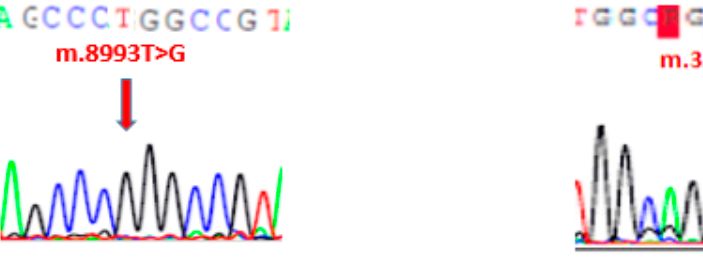
Figure 1. Electropherogram is showing m.8993T>G homoplasmic mutation and m.3243A>G hetero- plasmic mutation. Reference sequence is on the